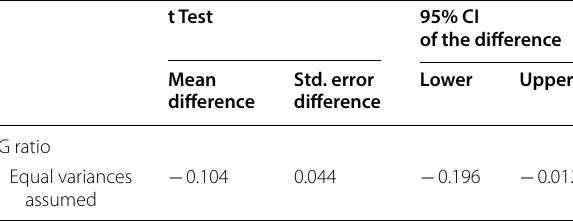
Table 3 Difference in G ratio for femoral nerve in